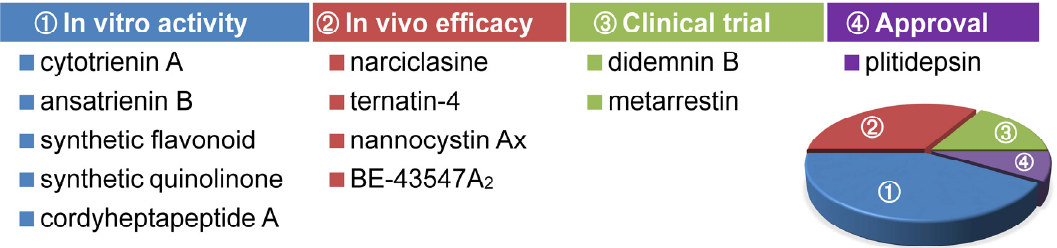
Table 3. Summary of eEF1A-targeting small-molecule agents on their anticancer efficacy and selec- tivity.